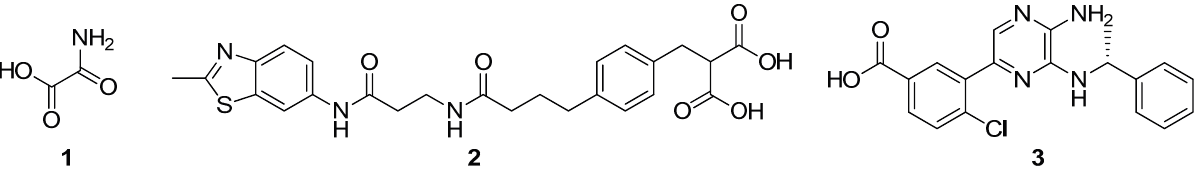
Figure 1. Representative LDH inhibitors deposited in the PDB in complex with h